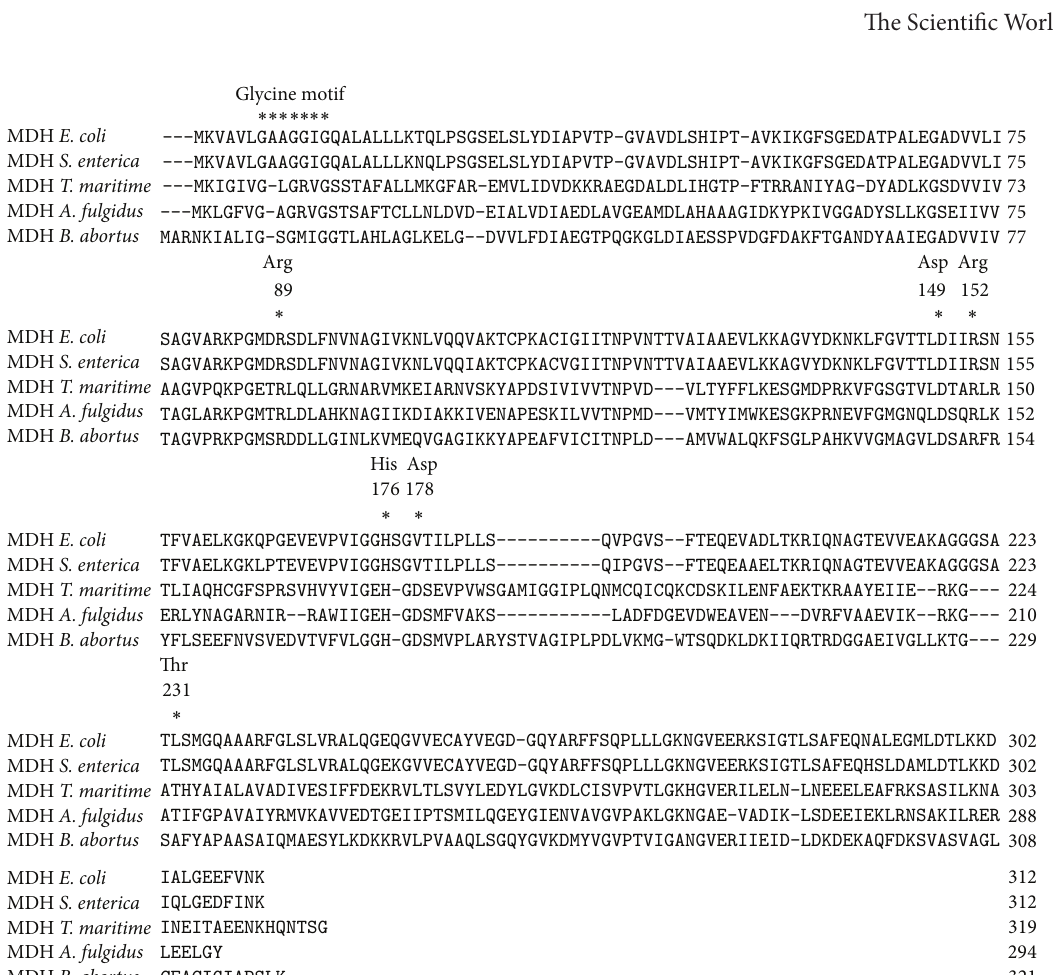
Figure 6: Sequence comparisons and bioinformatics analysis. Alignment of the amino acid sequences of MDH from E. coli K-12 (access number P61889), S. enterica (access number YP 002245258), T. maritime (access number P16115), A. fulgidus (access number Z85985), and B. abortus (access number NC 007618.1) by DNAstar 7.01 version. Gaps are marked by dots . Residues important for catalysis, coenzyme binding, and substrate binding are indicated by asterisks and numbered according to the system used for lactate